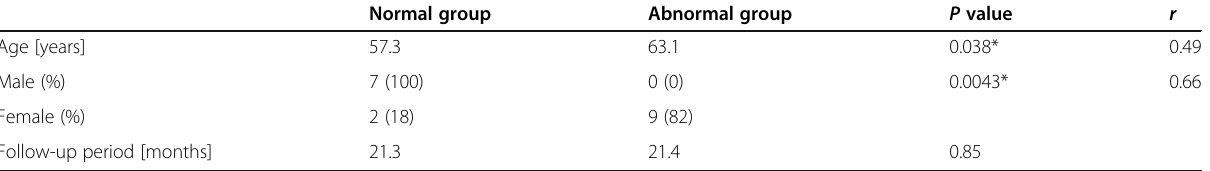
Table 2 Age, sex, and follow-up period between the normal and abnormal group Normal